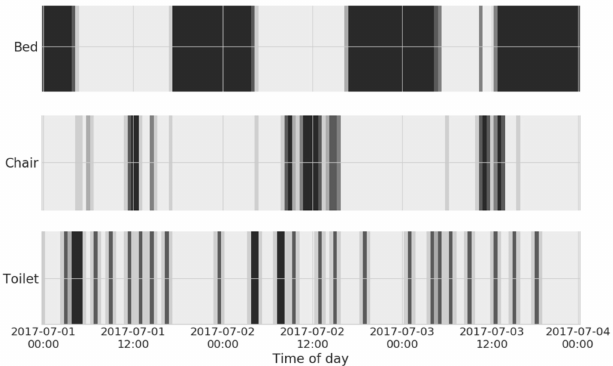
Figure 2. Activation patterns of home sensors, over a three-day timeframe. The darker color represents higher event counts detected within each time